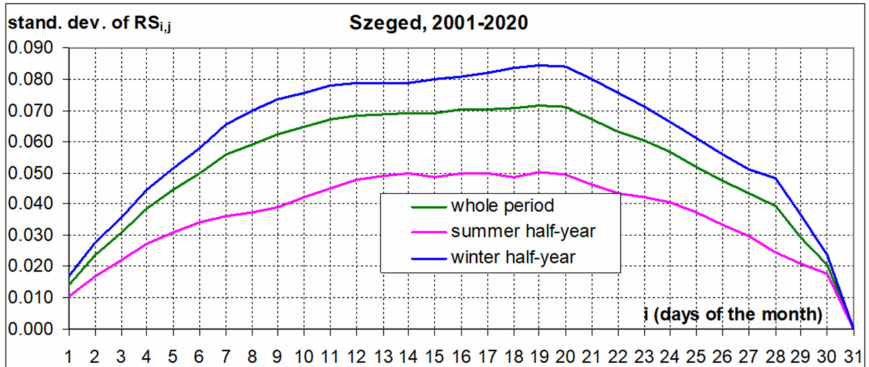
Figure 4. Monthly course of the standard deviation (J/cm 2 ) of the relative sliding sums RS i , j . The good agreement between the three statistics—mean, median and mode—also shows that the daily values of RS i , j were likely to be well-approximated by the normal distribution. Performing this approximation for the selected 10 days, we obtained that, with the exception of days 10, 11 and 18, the frequency distribution of RS i , j could be approximated to the normal distribution at the 0.05 significance level. Figure 5 shows the frequency distribution of RS i , j observed and approximated by the normal distribution on the 15th day of the months (whole period). That is, how many of all the (240) RS 15, j values fall within the given interval.